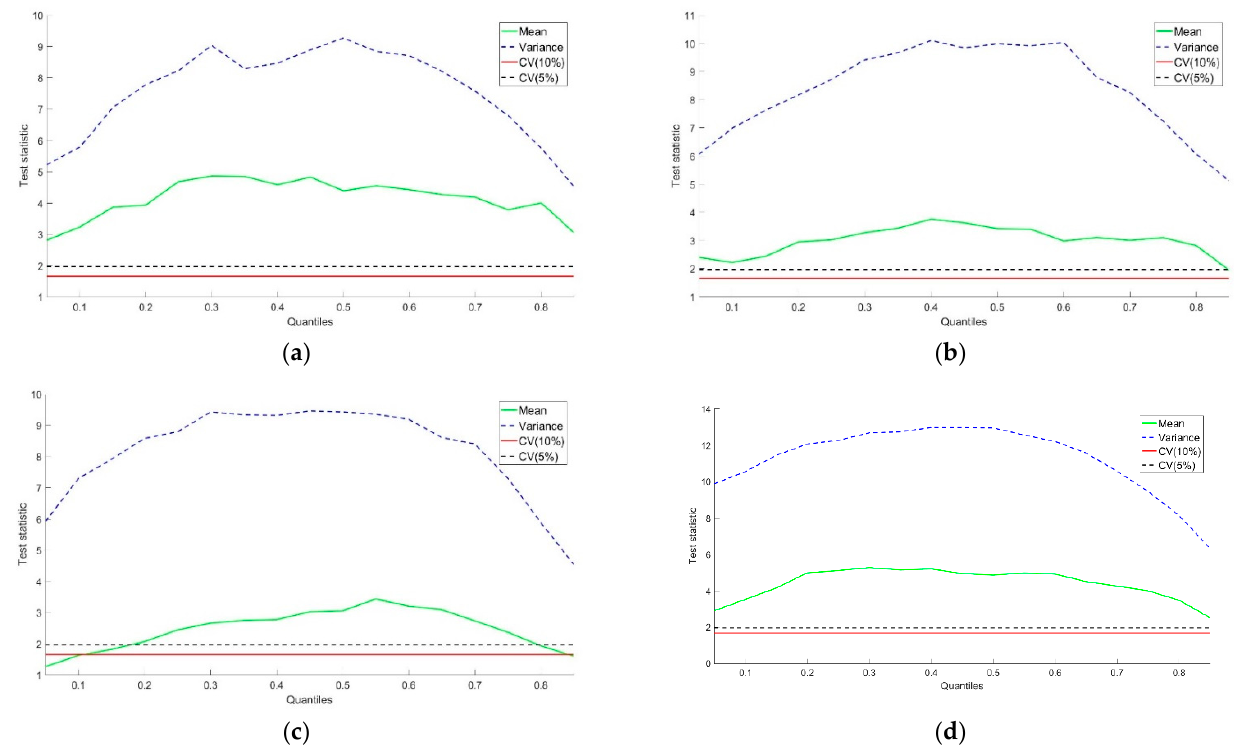
Figure 7. Non-parametric causality-in-mean, in-variance and the 5% and 10% critical values (CV) from gold returns to the stock market returns at various quantiles, respectively: ( a ) Gold-US; ( b ) Gold-CHINA; ( c ) Gold-UK; ( d ) Gold-JAPAN.